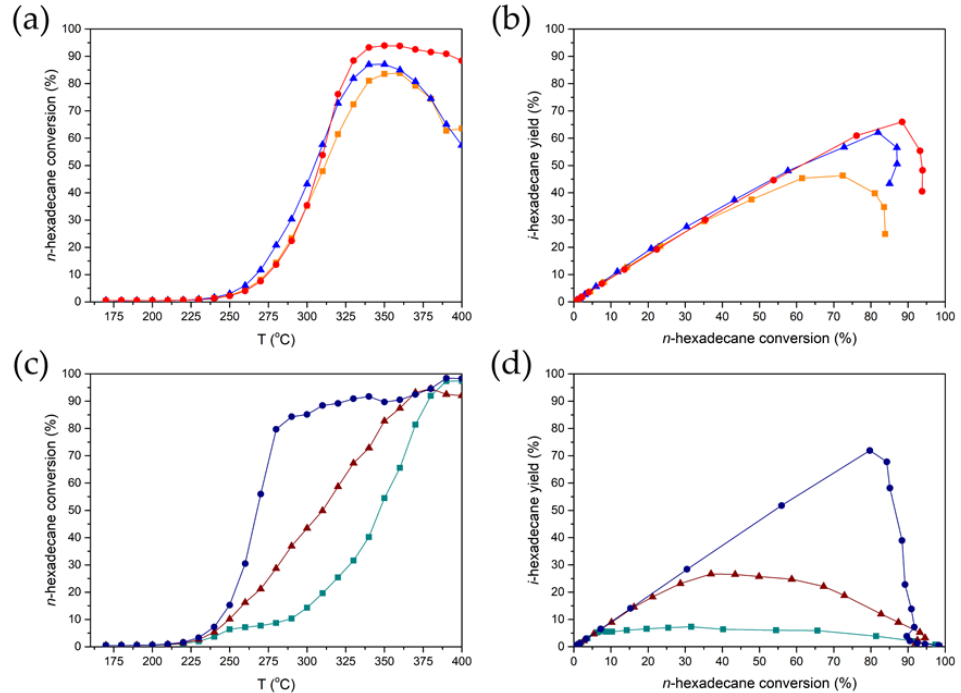
Figure 5. Results of the hydroconversion of n -hexadecane. ( a ) n -hexadecane conversion as function of the temperature and ( b ) i -hexadecane yield as function of the n -hexadecane conversion for Pd-SAPO-11/ γ -Al 2 O 3 CR (orange squares), Pd- γ -Al 2 O 3 /SAPO-11 (red circles) and Pd-SAPO-11/ γ -Al 2 O 3 DR (blue triangles). ( c ) n -hexadecane conversion as function of the temperature and ( d ) i -hexadecane yield as function of n -hexadecane conversion for Pd-ZSM-22/ γ -Al 2 O 3 CR (cyan squares), Pd- γ -Al 2 O 3 /ZSM-22 (dark blue circles) and Pd-ZSM-22/ γ -Al 2 O 3 DR (brown triangles). 3.5. The Effect of the Metal Nanoparticle Location on Hydrocracking Selectivities The cracking patterns are compared by plotting the selectivity for each product against the product carbon number. Figure 6 shows the product selectivities over the Pd/zeotype/γ -Al 2 O 3 catalysts during both n -heptane and n -hexadecane conversion. Next to isomerization, the main reactions are acid cracking, hydrogenolysis and dimerization cracking [21]. During the hydroconversion of n -heptane, the main products that are formed next to i -heptane are propane, n -butane and i -butane (Figure 6a,b). As i -butane and n - butane are products of different β -scission mechanisms [6], their respective ratios tell us more about the mechanisms involved. For SAPO-11-based catalysts, n -butane yields are very low, resulting in high i -butane/ n -butane ( i -C4/ n -C4) ratios. It shows that in all three catalysts, hydrocracking mainly occurs via the type B β -scission mechanism. This is a result of the relatively mild acidity of SAPO-11 [50,51], decreasing its ability to catalyze the energetically less favorable type C β -scission. ZSM-22 catalysts, on the contrary, pro- duce less i -butane, with i -C4/ n -C4 ratios ranging between 1.3 and 1.7, approaching a 50:50 ratio. This indicates that type B and type C β -scission mechanisms [6,52] occur to a rather similar extent. The higher acidity of ZSM-22 allows for more type C β -scission producing